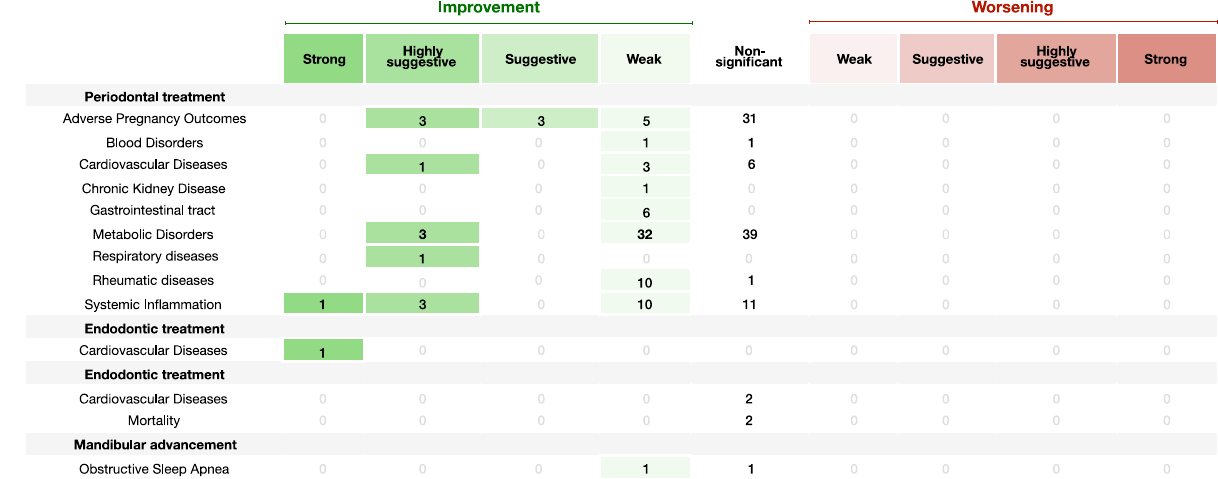
Fig.6|Diagramshowingresultsfromtheumbrellareviewgradingtheevidence oftheeffectoforaltreatments(periodontaltreatment,endodontictreatment, dental treatments or mandibular advancement) on NCDs. The right side dis- plays associations that increase the risk for the respective systemic NCD (in red),